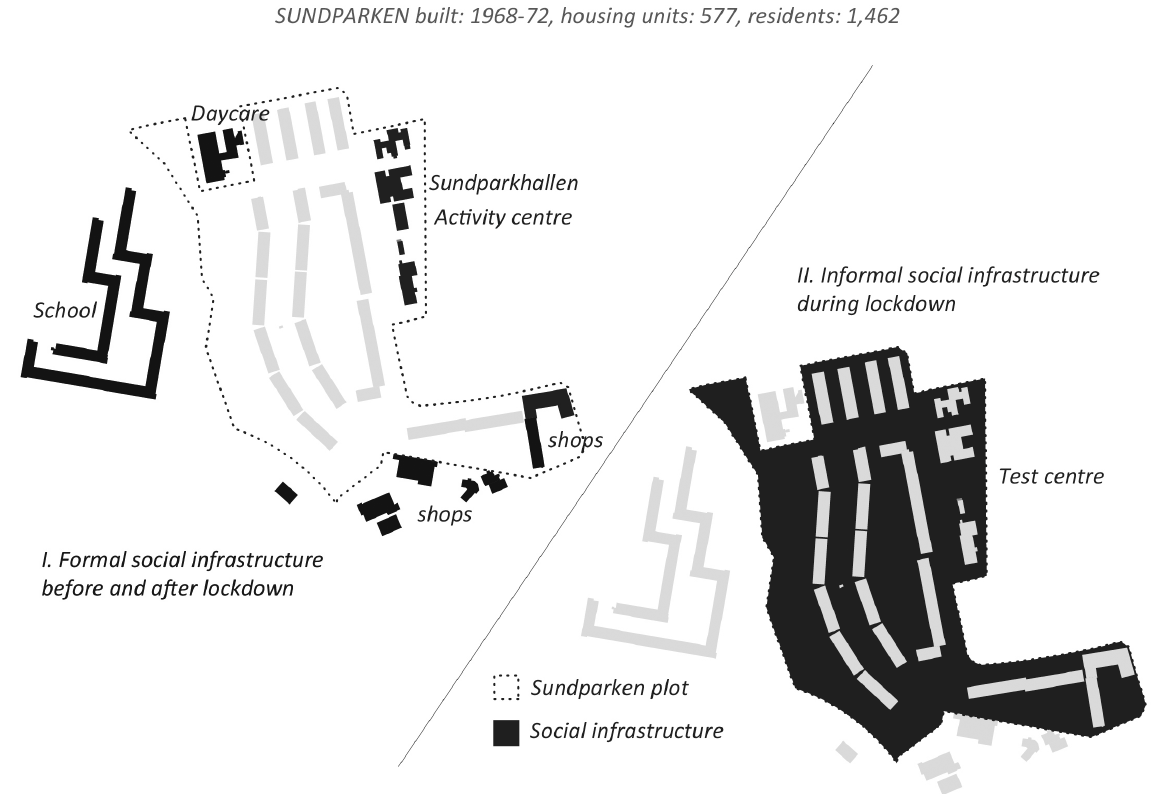
Figure 3. Social infrastructure before/after (I) and during the lockdown (II) in Sundparken. during the shutdown, as many residents followed govern‐ ment instructions and stayed